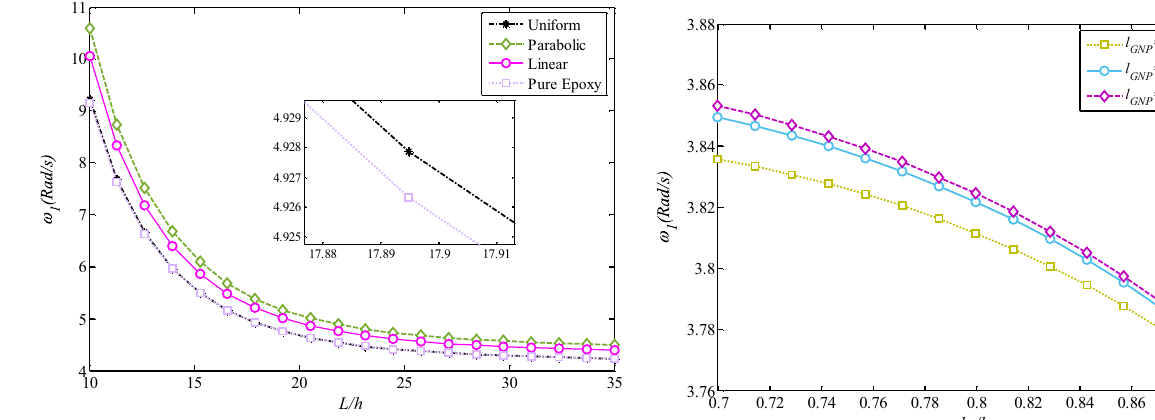
Figure 8: E ff ect of GNPs Geometrical parameters versus thicknesses of the layers ratio on the frequencies ( h = 0.01 m , R = 100 h , L = 20 h